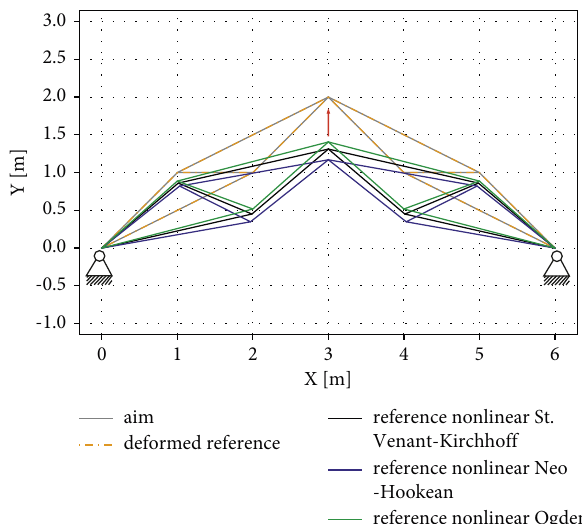
Figure 20: Convergence of the nonlinear self-weight problem, employing either the complete solution matrix C incomplete matrix from equation 32, respectively, 43. Both converge to the approximately same solution but show diferent convergence rates.